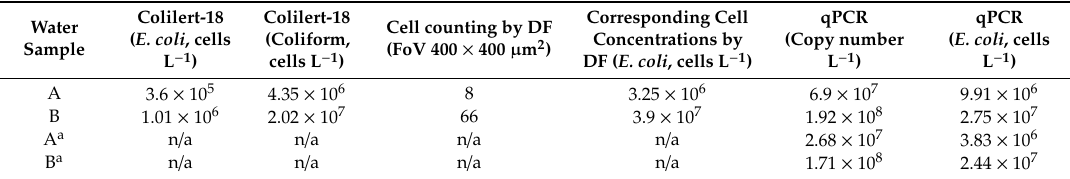
Table 2. Quantification of bacteria, in cells L − 1 , in Samples A and B by the IDEXX (Colilert-18), dark field (DF), and quantitative polymerase chain reaction (qPCR)